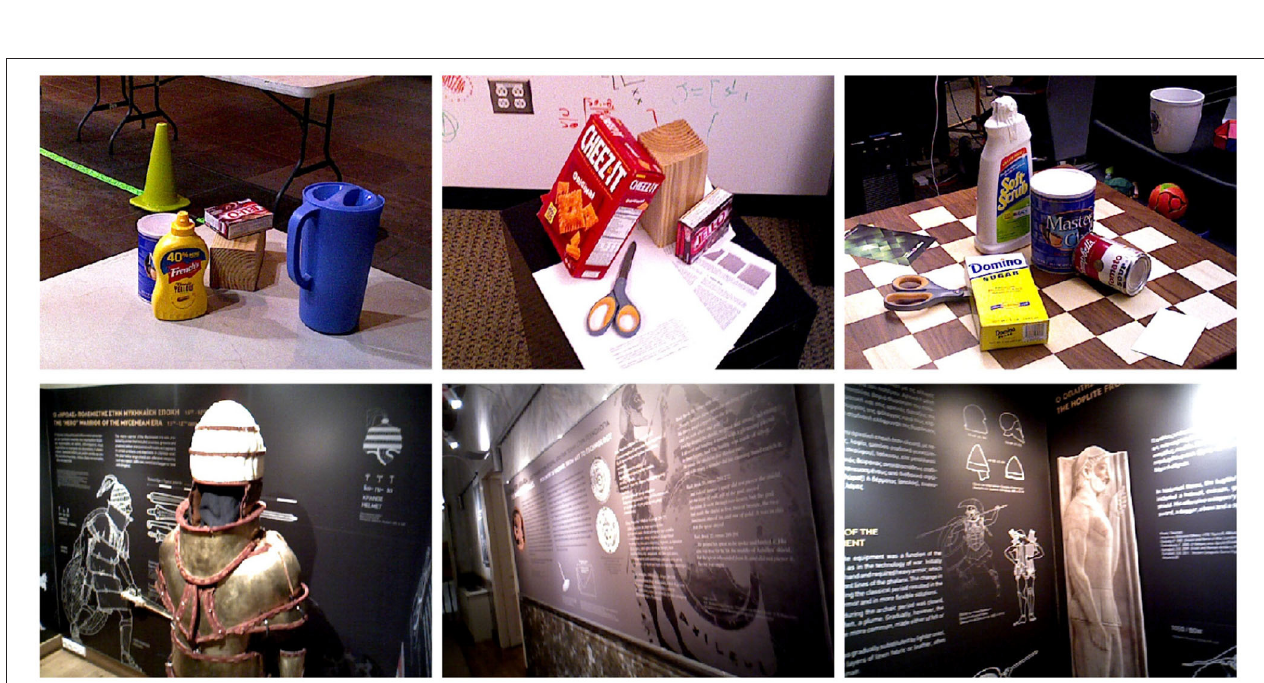
FIGURE 2 | Image samples from the employed datasets. Each image corresponds to a single class. Top : Frames from the YCB92 dataset. All objects and the surface they lay on, are considered as a single object. Bottom : Frames from the Muselearn dataset. Each frame shows a different museum exhibit.